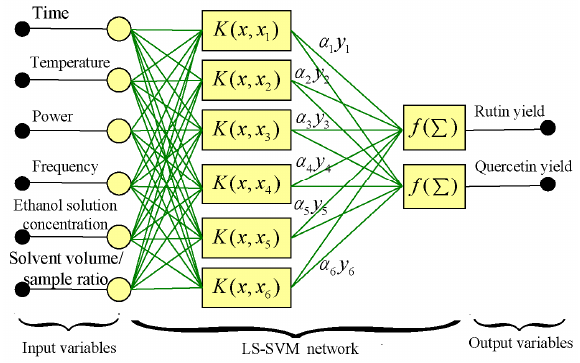
Figure 9. Structure diagram for ultrasonic extraction process based on least squares support vector machine (LS ‐ SVM) model.